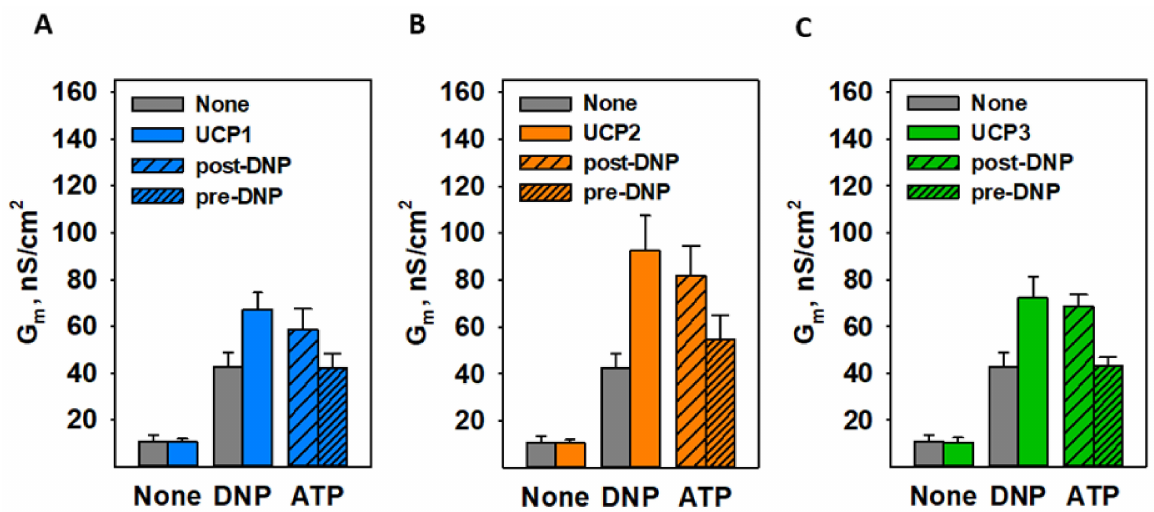
Figure 4. ATP decreased DNP-mediated proton transport enhanced by UCP1 ( A ), UCP2 ( B ), and UCP3 ( C ). Here, 4 mM of ATP was added either post-DNP (medium pattern) or pre-DNP (fine pattern). The experimental conditions were similar to those in Figure 2.